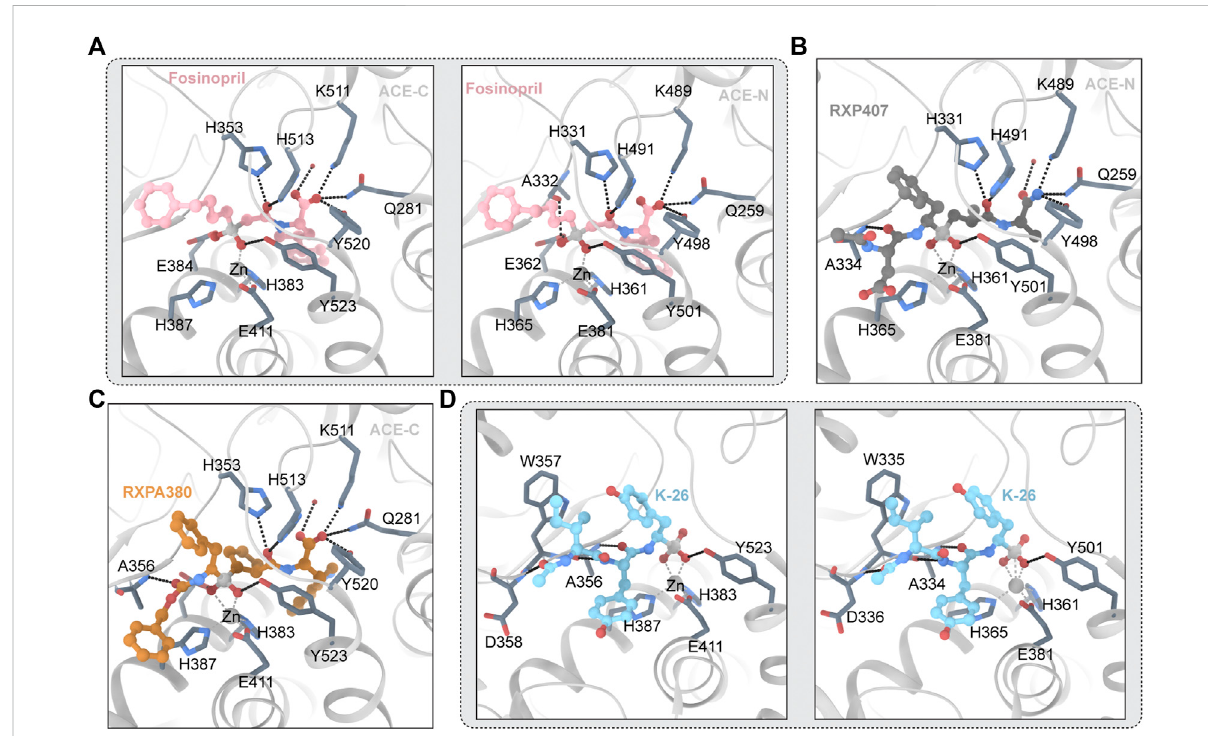
FIGURE 4 (A) Fosinopril and ACE (PDB ID:7Z70 7Z6Z) The ligand molecule is shown in pink by balls and sticks. (B) RXP407 and ACE (PDB ID:3NXQ) The ligand molecule is shown in dark blue by balls and sticks. (C) RXPA 380 and ACE (PDB ID:2OC2) The ligand molecule is shown in orange by balls and sticks. (D) K-26 and ACE (PDB ID:4BZR 4BZS) The ligand molecule is shown in vlue by balls and